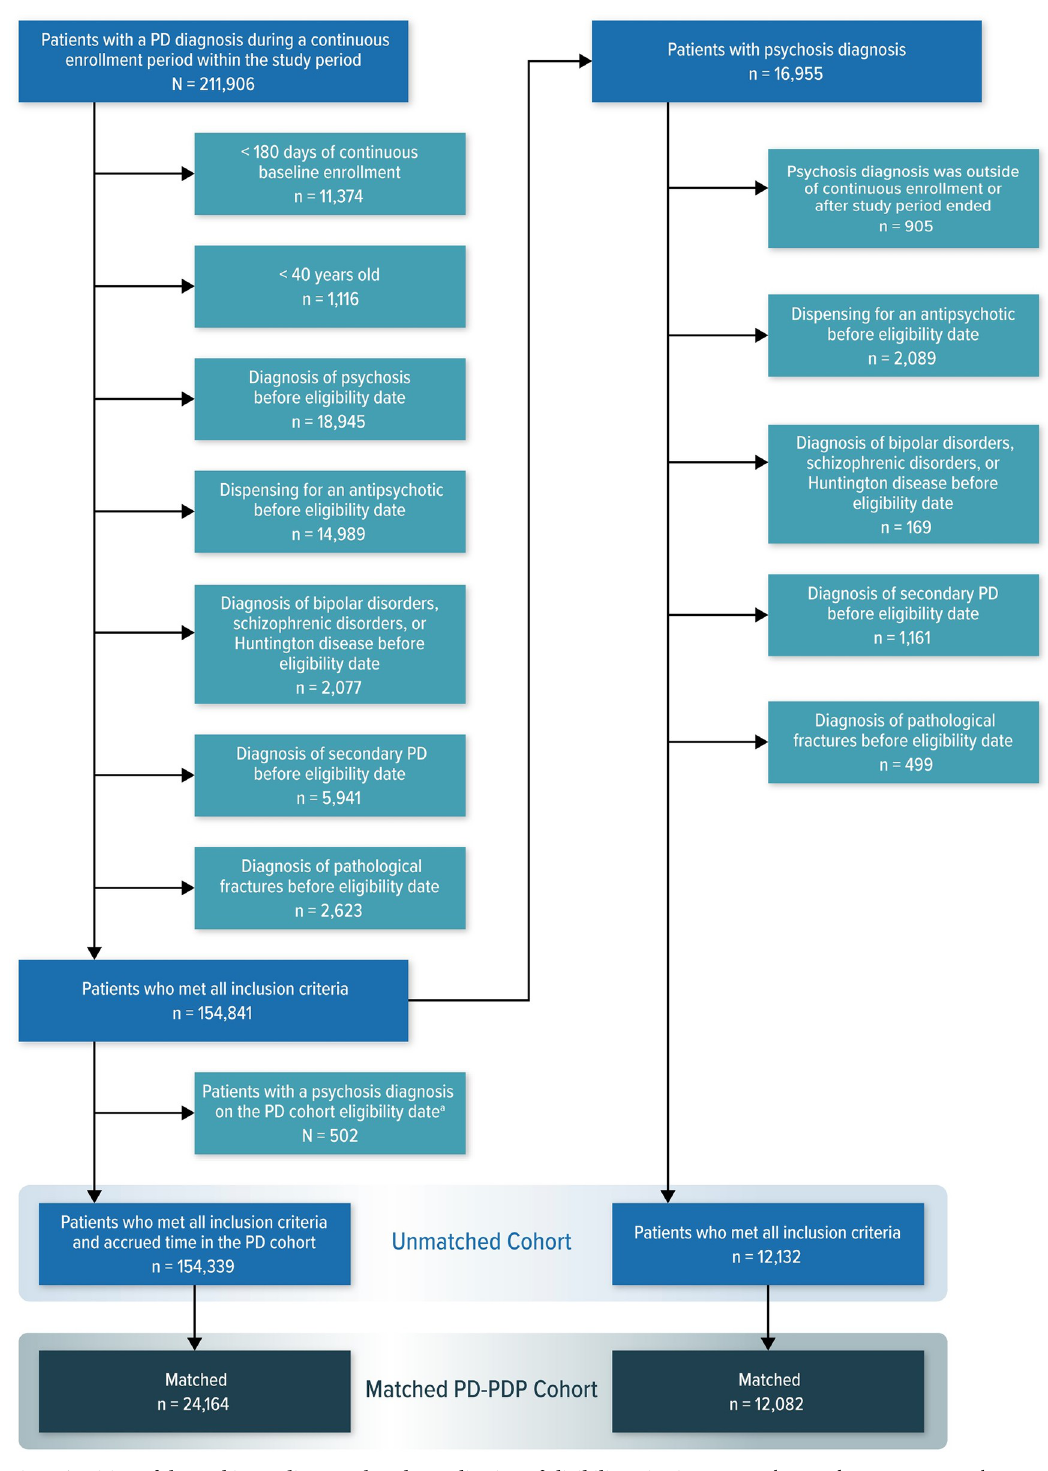
Fig 1. Attrition of the Parkinson disease cohort by application of eligibility criteria. PD = Parkinson disease; PDP = Parkinson disease with psychosis. a Those 502 patients with a PD diagnosis and all eligibility criteria could not contribute time to the PD without psychosis group because they were diagnosed with psychosis on the cohort eligibility date.